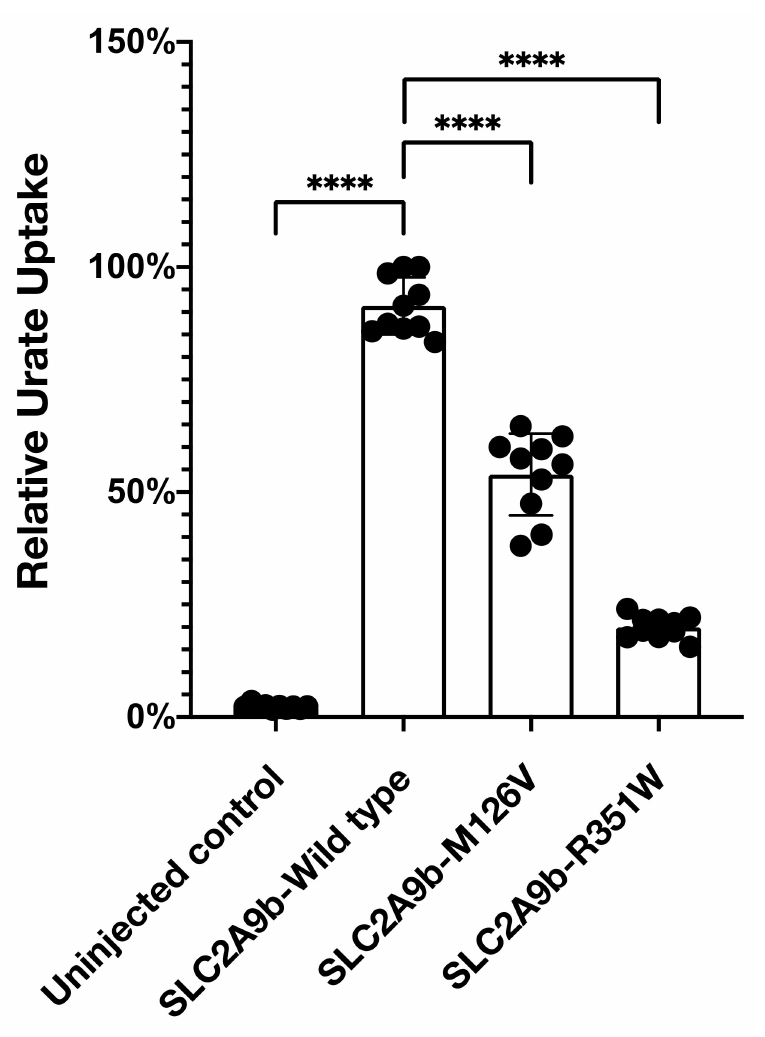
Figure 5. Met126Val mutation reduces uric acid uptake. Uric acid uptake assay was performed as described in the Methods section. M126V mutation in SLC2A9b reduced uric acid uptake by 45% and R351W mutation decreased by 70%. Histogram depicts relative urate uptake level ( n = 10). Quantification with one-way ANOVA (Dunnett’s multiple comparisons test), **** p < 0.0001. Data represent the mean ± S.D. of three individual experiments. **** p <